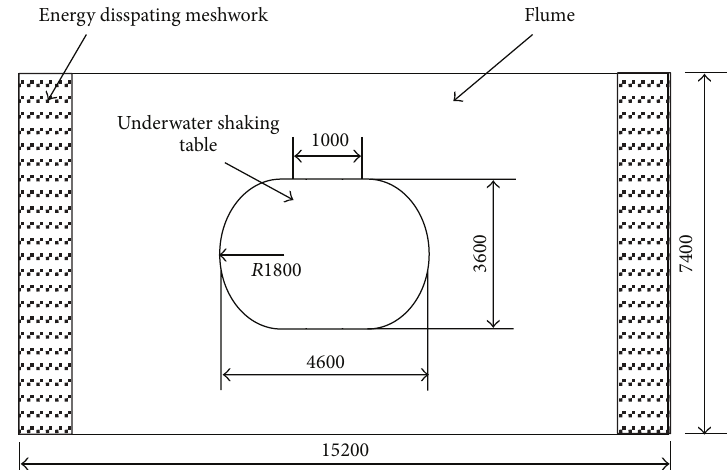
Figure 4: The sketch of the underwater shaking table (units: mm).